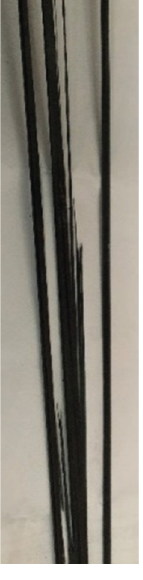
Figure 7: Tension test of CFRP. Table 2: Material properties of CFRP.